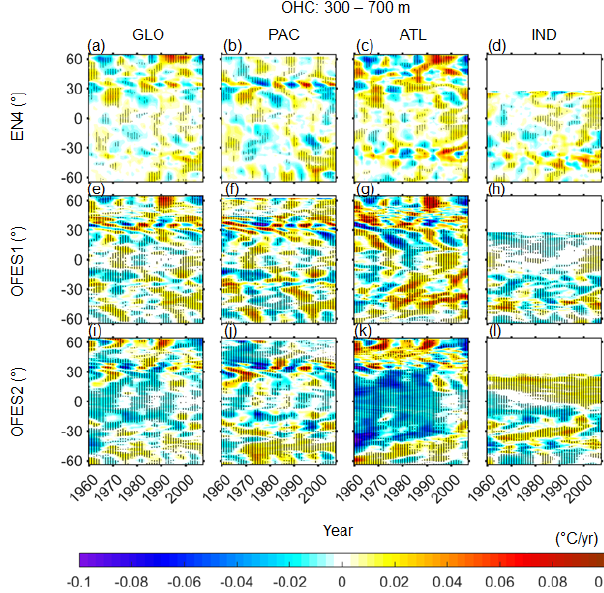
Figure 8. Temporal evolution of 10-year rolling trend of the zonal averaged potential temperature change in the upper layer of the ocean (0–300m). Left to right: global, Pacific, Atlantic, and Indian oceans. Top to bottom: EN4, OFES1, and OFES2. Horizontal axis: year; vertical axis: latitude. Stippling indicates the 95% confidence level. The HV and SP counterparts are in the Supplement, Figs. S1– S2.